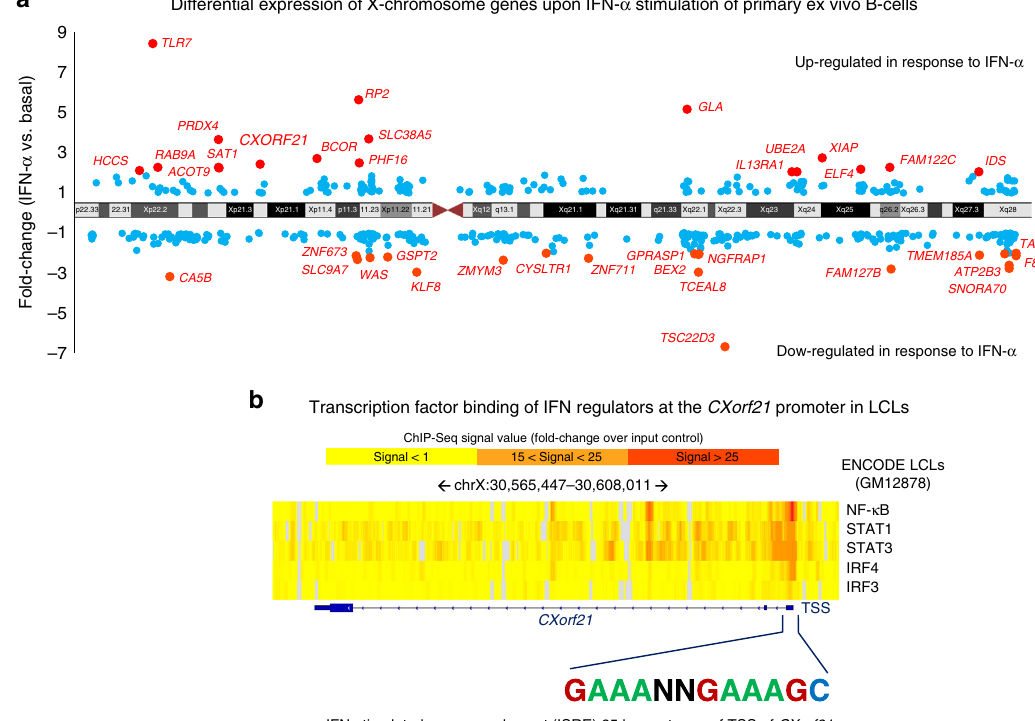
Fig. 5 CXorf21 as an interferon response gene. a Differential gene expression of X chromosome genes in response to IFN- α stimulation (harvested after 6 h) in primary ex vivo B cells from healthy females of European ancestry (in-house data). Genes highlighted in red are signi fi cantly differentially expressed ( q < 0.01; absolute fold-change >2). b Epigenetic landscape of CXorf21 using ENCODE transcription factor binding data in LCLs (GM12878 cell line). All fi ve transcription factors have genome-wide signi fi cant binding sites at the CXorf21 promoter. Heat colour is a function of signal strength (fold-change over